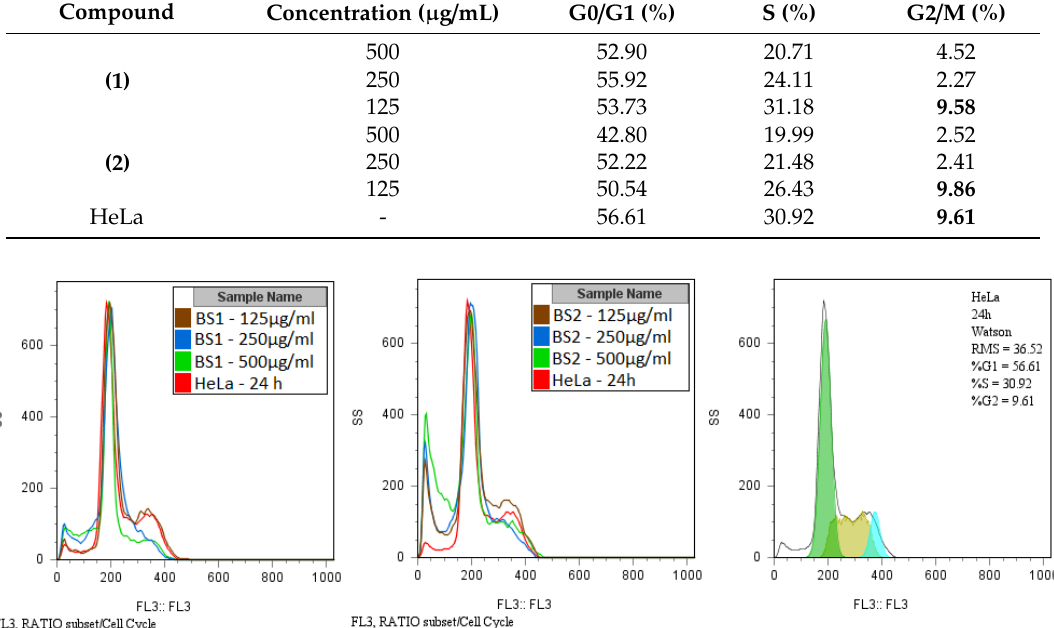
Figure 9. Overlapped flow cytometry histograms showing the influence of compounds on the cell cycle phases.